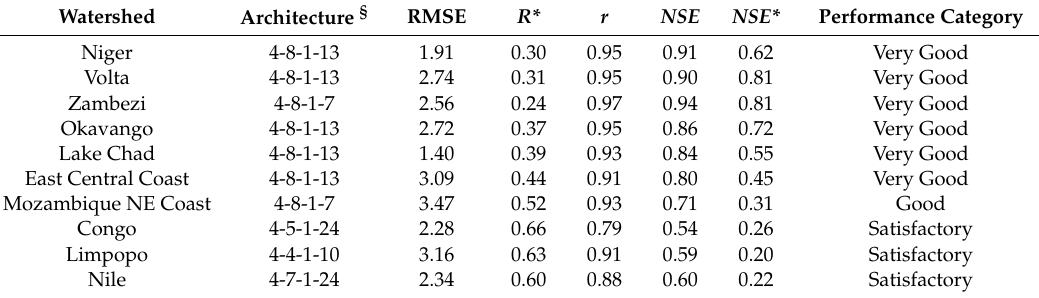
Table 1. Nonlinear autoregressive with exogenous input (NARX) configurations along with simulations performance